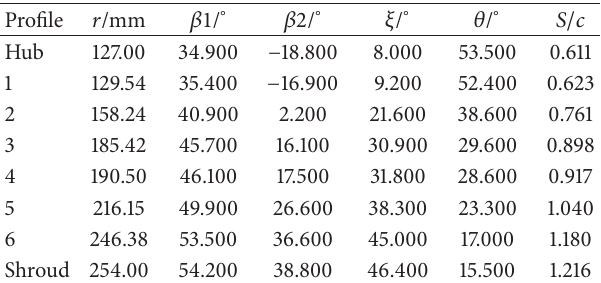
Table 1: Blade elements of fan-rotor